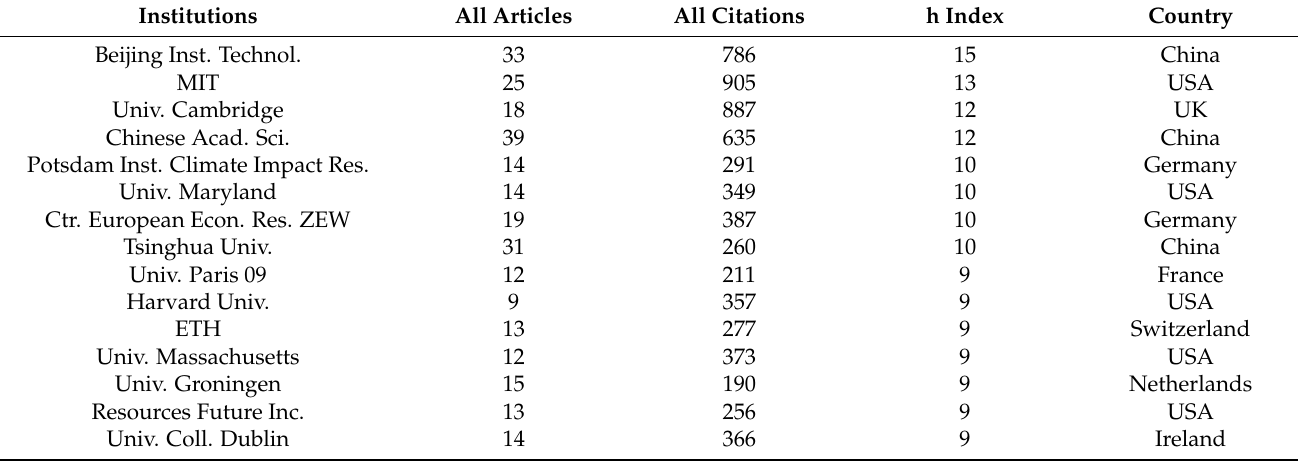
Table 4. The top 15 productive